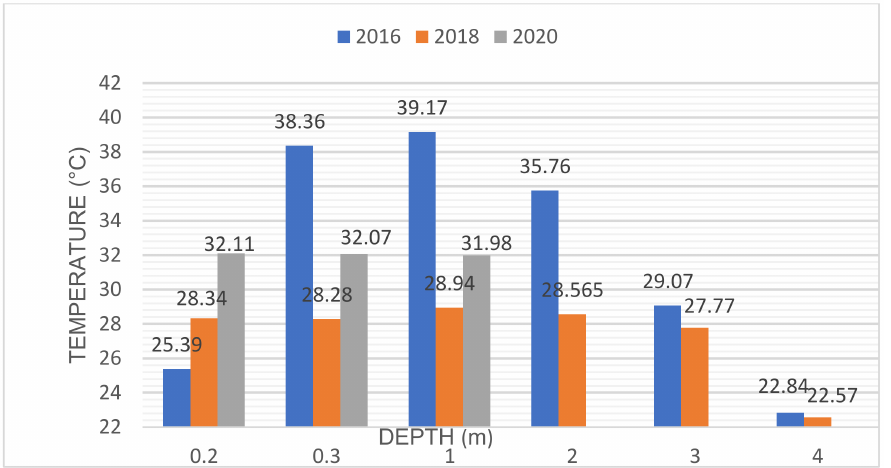
Figure 4. Temperature values at several depths of Lake